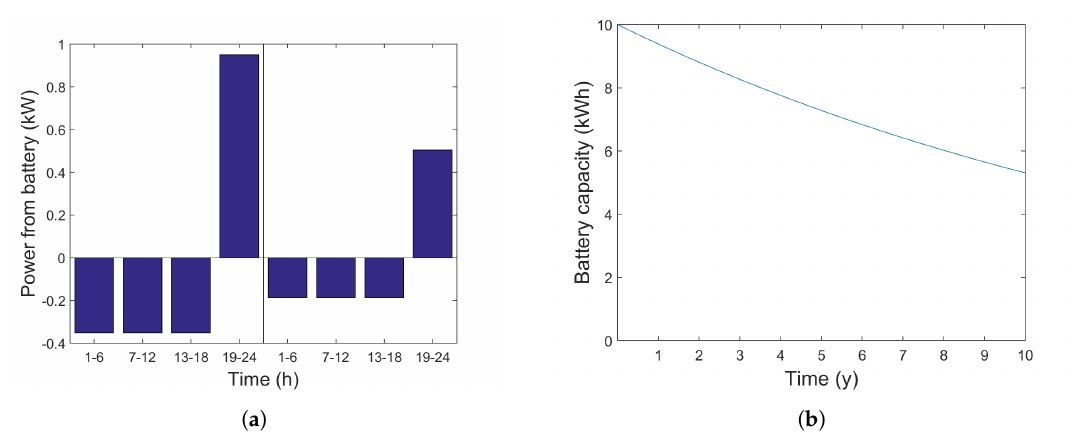
Figure 5. Optimal operation for a “simple tariff” example during a 10 years period. ( a ) p C and p D (positive). Left: First day. Right: Last day. ( b ) Remaining capacity BC d t